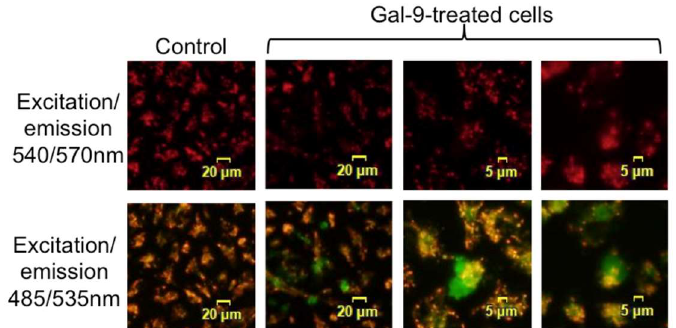
Figure 4. Gal-9 induces the collapse of the mitochondrial potential. KYSE-150 cells were treated with 100 nM Gal-9 for 3 h and then treated with JC-1 dye for 15 min. Cells were then visualized by a fluorescent microscope to examine the conversion of red to green color in healthy and apoptotic cells, respectively. Healthy cells were stained red with JC-1 dye using a filter set excitation/emission 540/570 nm. Apoptotic cells were stained green with JC-1 dye using a filter set excitation/emission 485/535 nm, suggesting that a collapse of mitochondrial potential by Gal-9 treatment. Scale bars are shown for the images.